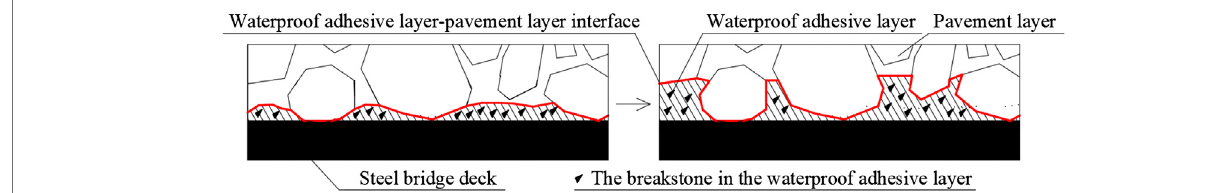
FIGURE 4 | Waterproof adhesive layer interface.